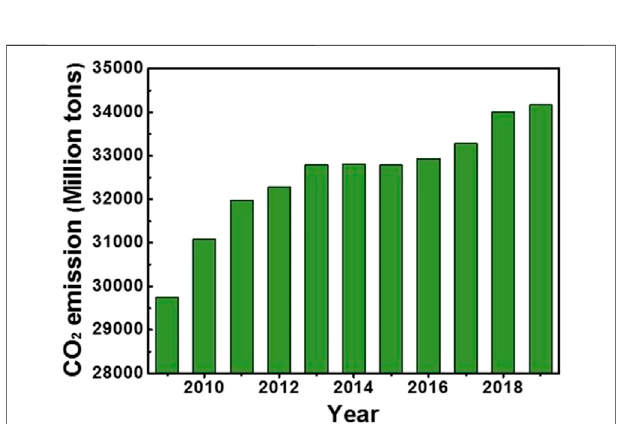
FIGURE 2 | Global CO 2 emission from the activities related to the combustion of oil, coal and natural gas (Dudley, 2019).